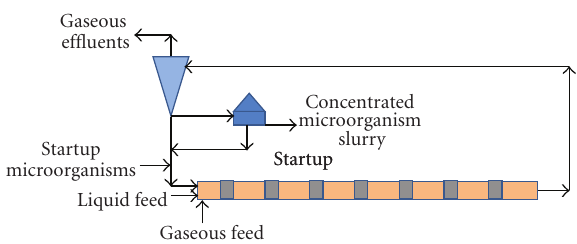
Figure 1: Schematic representation of a pipe-loop bioreactor sys-